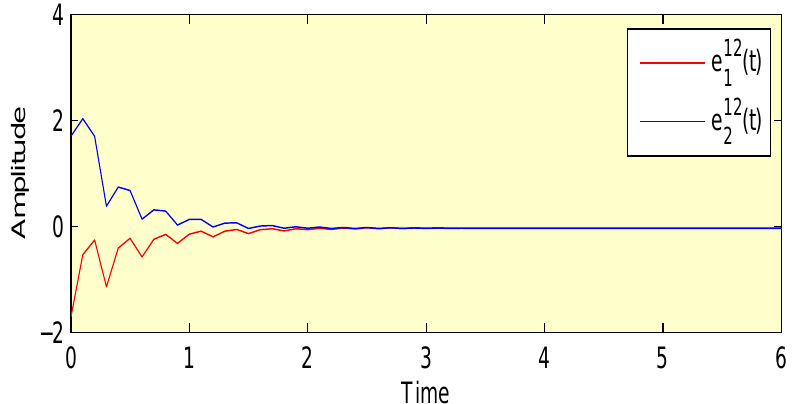
( t ) , (cid:101) 12 ( t ) of NN model (11) under con- 2 1